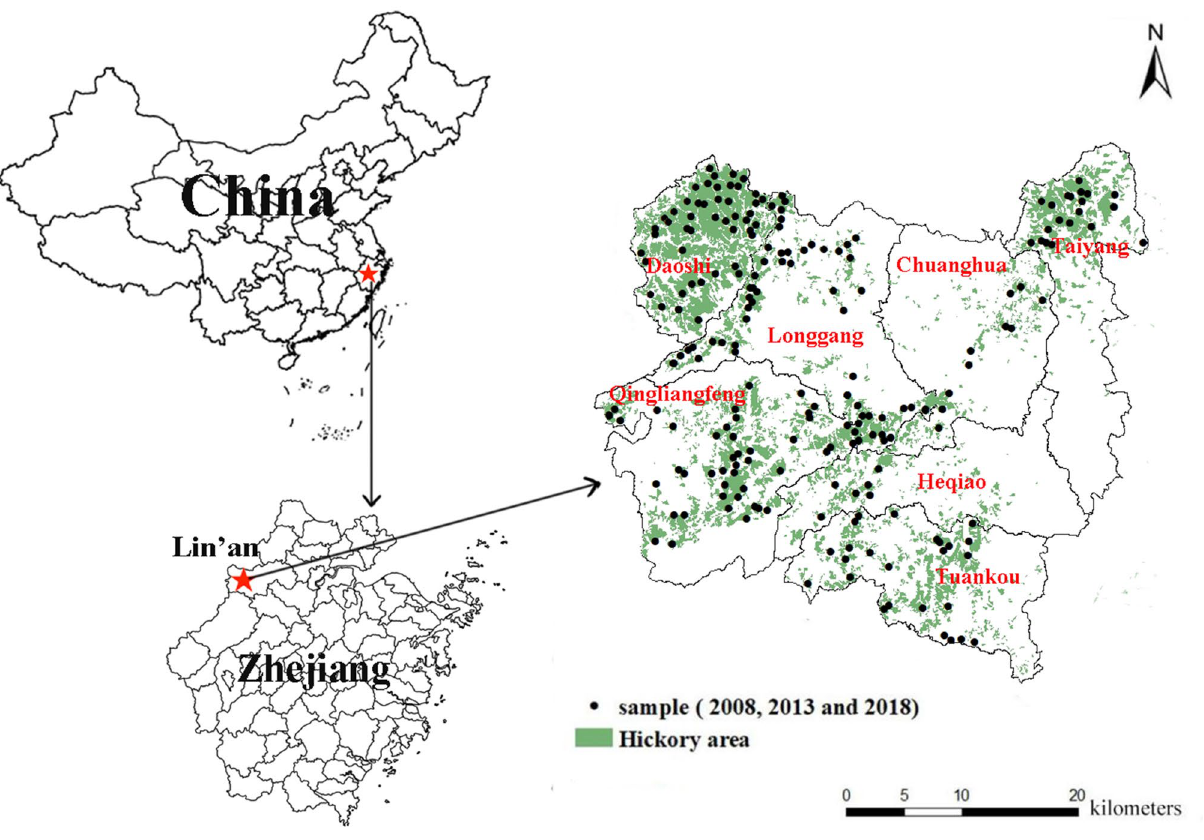
Figure 5. Location of the study area in Lin’an city, Zhejiang Province, China. This map was created in ArcGIS desktop